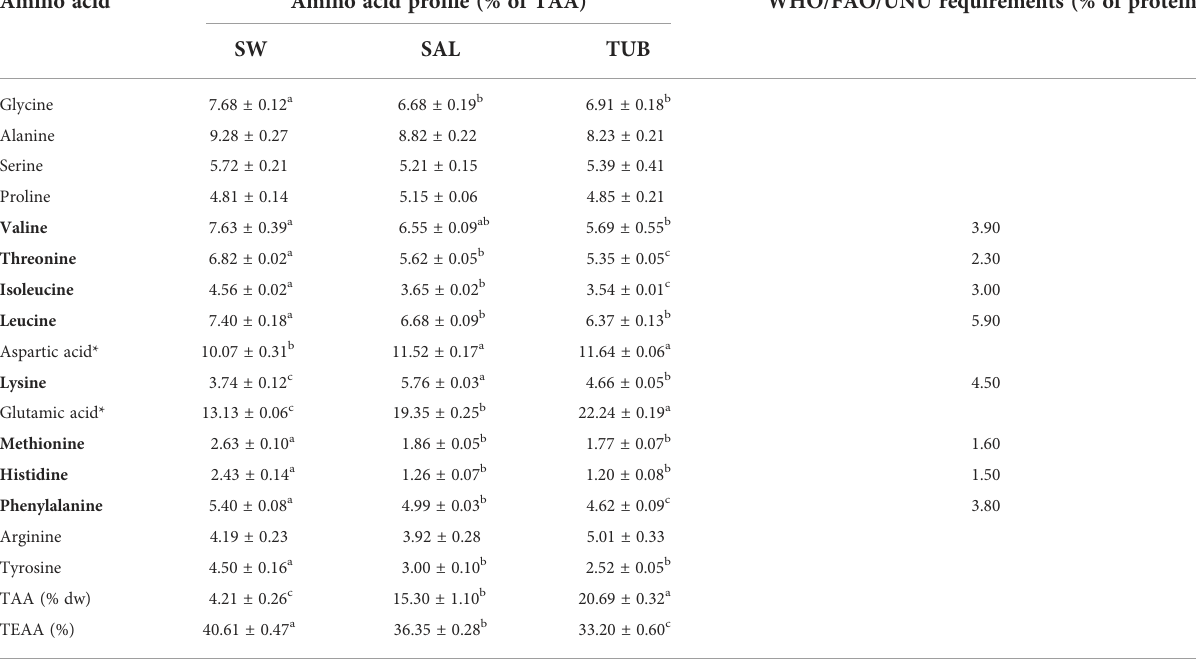
TABLE 4 Amino acid pro fi le (% of TAA) of dried biomass of Ulva fenestrata cultivated in seawater control (SW) and the two herring production process waters salt brine (SAL) and tub water (TUB) (mean ± SEM, n = 3), as well as the amino acid pro fi les (% of protein) recommended by WHO/ FAO/UNU (2007).